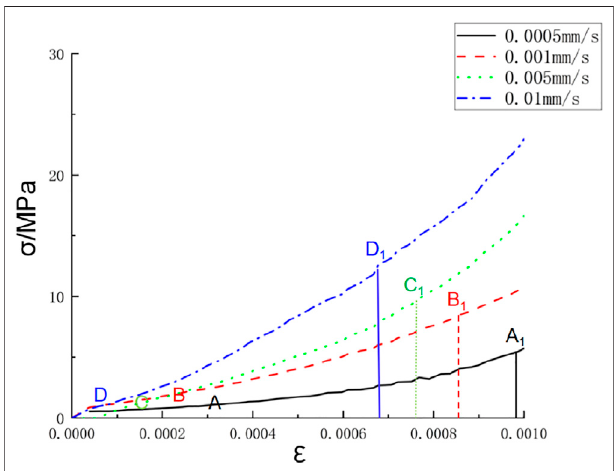
FIGURE 8 | Stress – strain curves of specimens in initial compaction